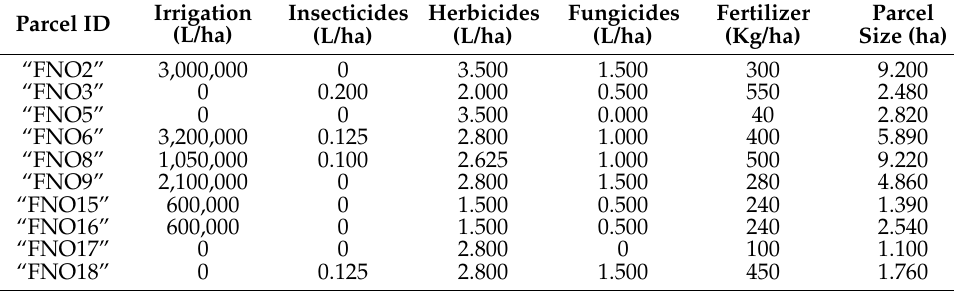
Table A1. Intensification parameter raw